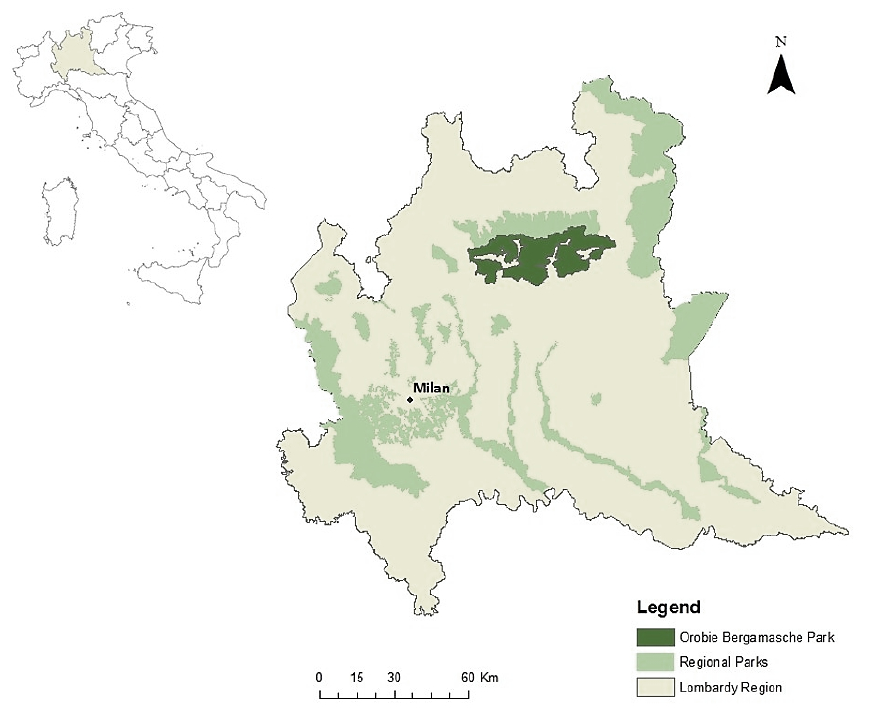
Figure 1: Orobie Bergamasche Regional Park, in Lombardy